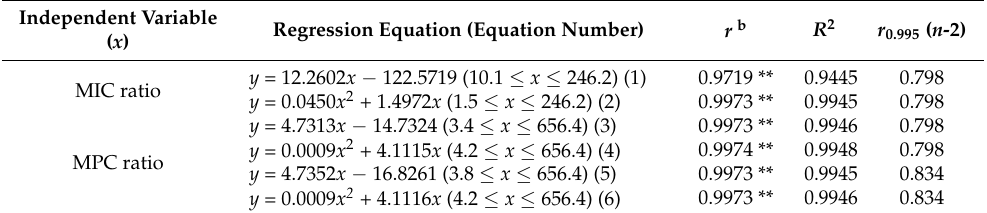
Table 4. Regression equations between the MPSI ( y ) and the MIC (or MPC) ratio ( x ), of two agents in drug combinations. ( n = 9) a